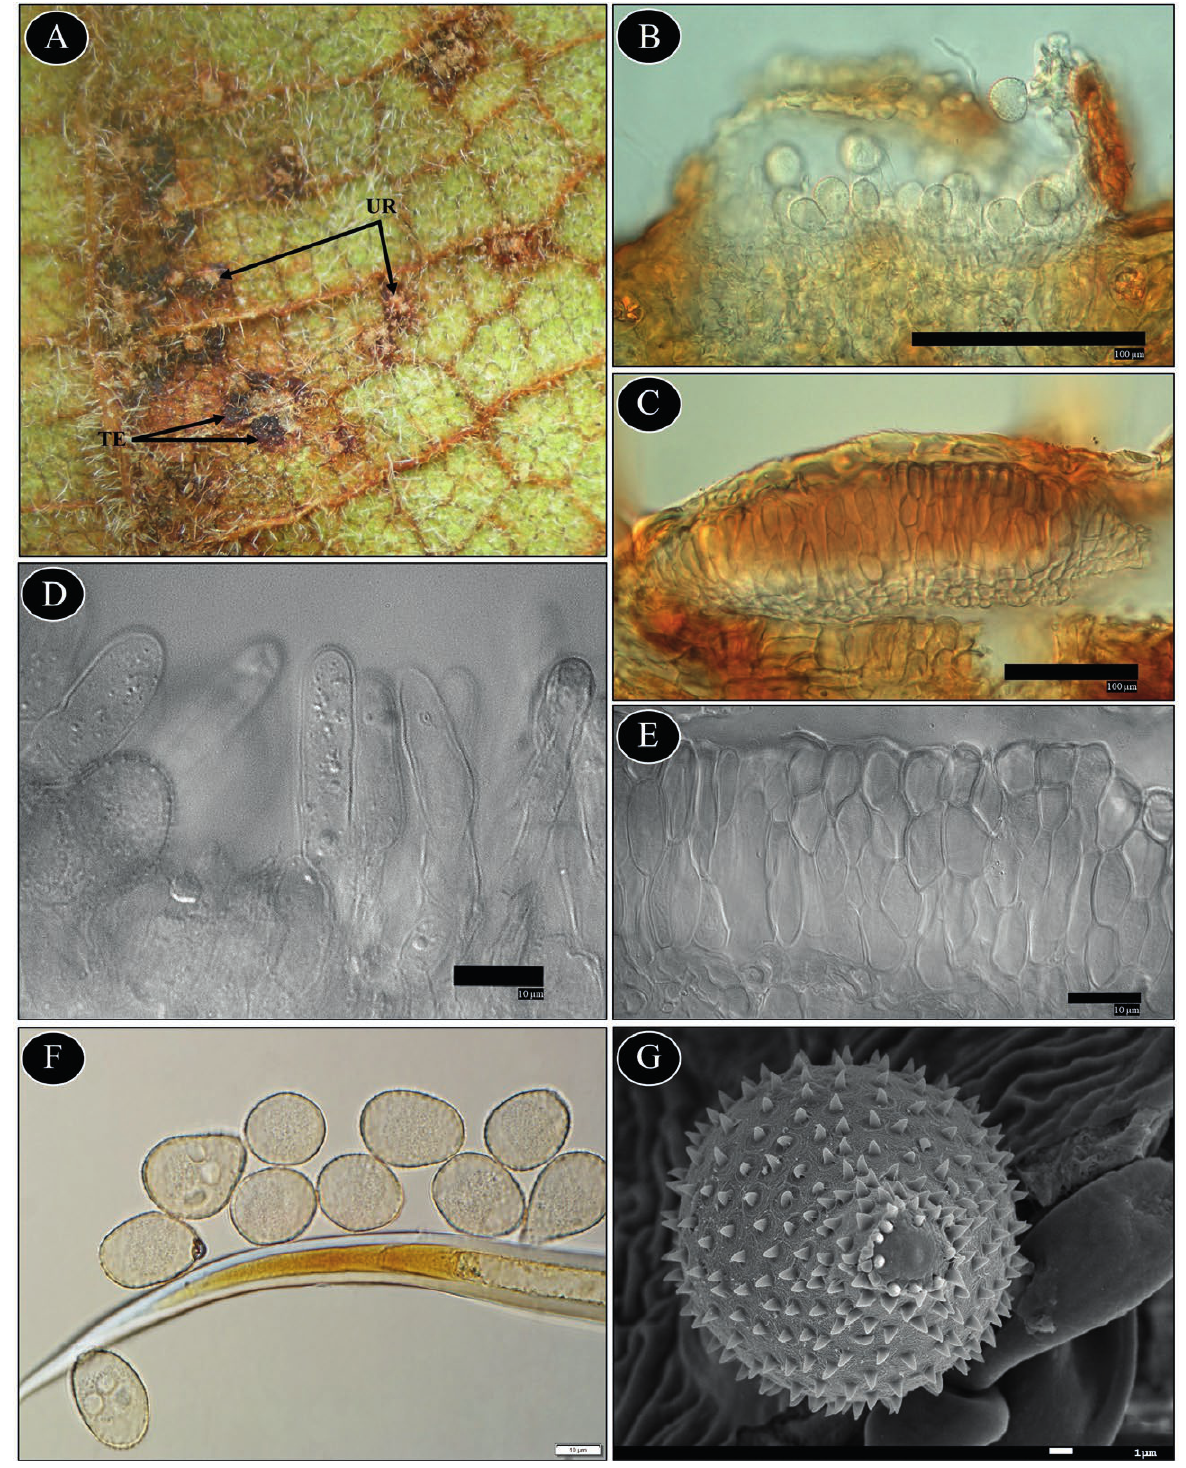
Figure 3. A, Uredinia (UR) and telia (TE) of Phakopsora nishidana on the abaxial surface of a leaf of Ficus carica . B, transverse cross section through a subepidermal erumpent uredinium, and C, a non-erumpent telium. D, thin-walled cylindrical paraphyses in a uredinium of P. nishidana . E, teliospores, F, thin-walled urediniospores (germ pores are obscure), and G, scanning electron micrograph showing ornamenta- tion and hilum of a P. nishidana urediniospore. Scale bars in B to E represent values indicated below each